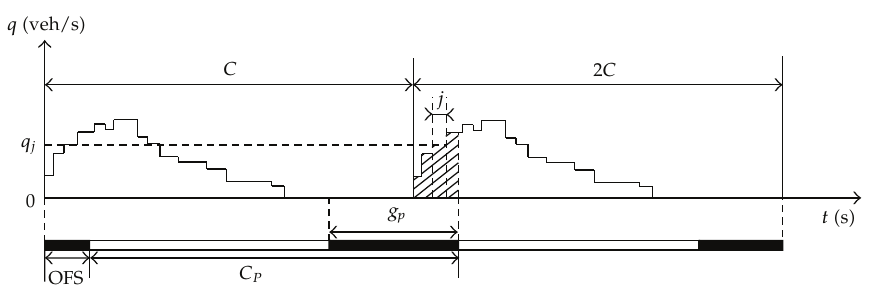
Figure 2: The establishment of first system optimal model on the basis of vehicle flow-time of crosswalk (cid:4) signal single cycle of pedestrian (cid:5) .